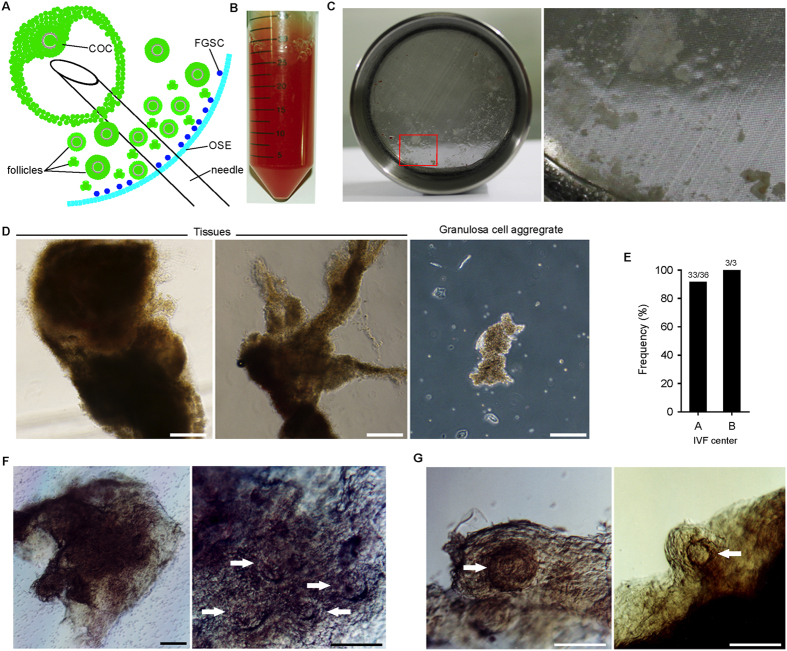
Scarce ovarian tissues exist in follicular aspirates.(A) Scheme of transvaginal oocyte retrieval performed in IVF centers showing preantral follicles and FGSCs possibly captured along with the mature oocytes. COC, cumulus-oocyte complex; OSE, ovarian surface epithelium. (B) Representative image of FAs in a 50-mL tube obtained from IVF centers. (C) A 30-μm nylon cell strainer with ovarian tissues and granulose cell aggregates from FAs (left). The red box is enlarged on the right. (D) Representative images of ovarian tissues (left, middle) and granulosa cell aggregates (right) captured from FAs showing distinct morphologies. (E) Proportion of samples containing ovarian tissues. (F) Bright-field images of human ovarian cortical tissue containing preantral follicles captured from FAs. The left image is enlarged on the right showing preantral follicles (white arrows). (G) After 2 days of culture in vitro, the preantral follicles (white arrows) were visible. Scale bars: 50 μm (D), 100 μm (F,G).